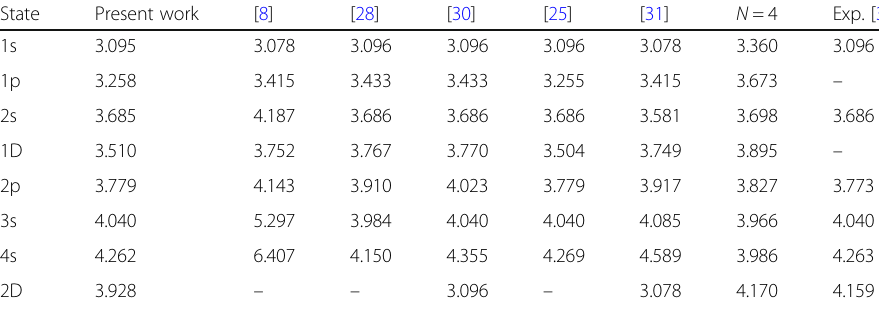
Table 1 Mass spectra of charmonium (in GeV) ( m c = 1.209 GeV, a = 0.01 GeV 2 , b = 14.94, d = − 15.04 GeV − 1 , c = 0.02 GeV 3 , δ = 1.7